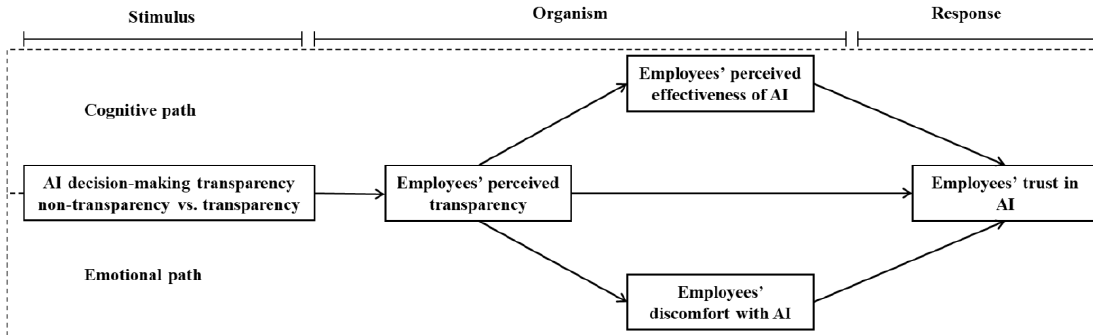
Figure 1. Research model.